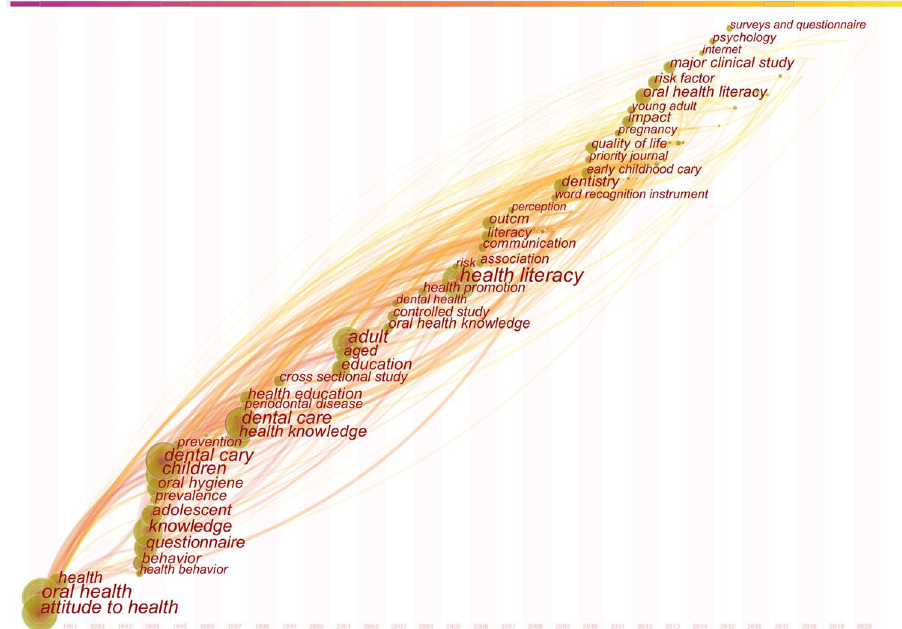
Fig. 7 The time zone view of keywords. The time zone view of co-occurring keyword from publications in oral health literacy research.